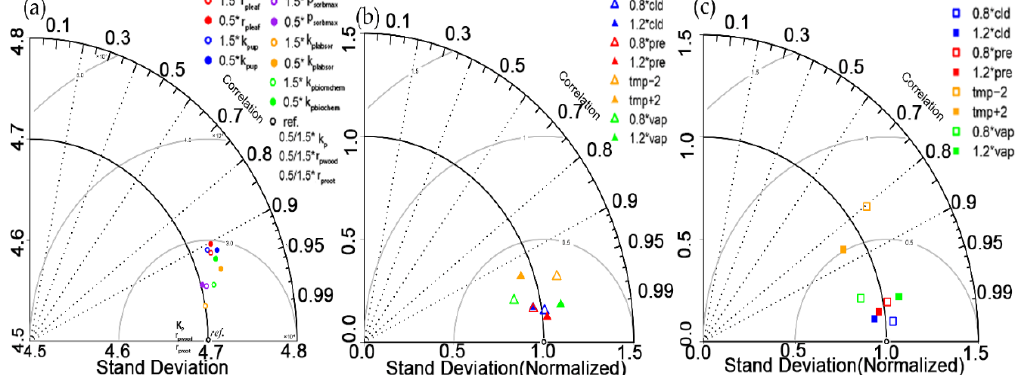
Figure 6. Taylor diagram assessing the sensitivity of ( a ) GPP to variations in model parameters, ( b ) GPP to meteorological factors and ( c ) amount of leaf phosphorus to meteorological factors. In Figure 6a showed the quality of observed GPP and the simulated GPP by all model parameters that were listed in Table 1. 1.5* parameter = +50% and 0.5* parameter = −50% in ( a ), while in ( b ), 0.8* factor